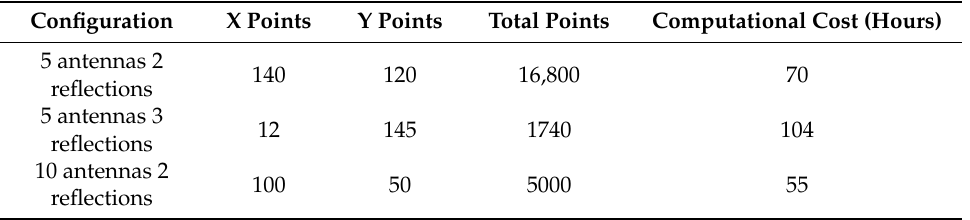
Table 2. NewFasant computational cost.